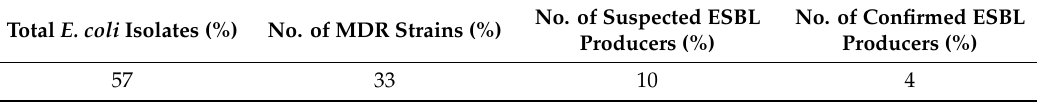
Table 3. Distribution of the bla TEM and bla CTX-M genes among E. coli